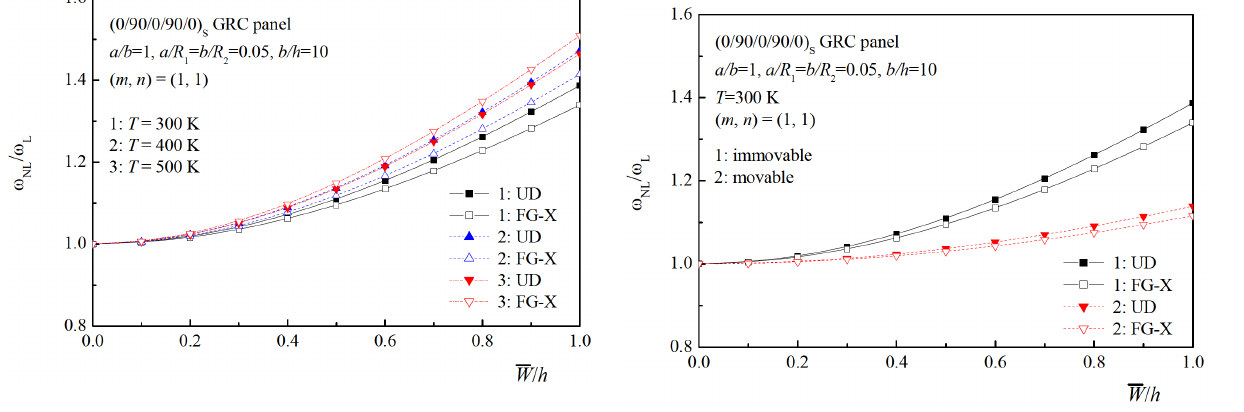
FG- Λ type with [(0.03) 2 /(0.05) 2 /(0.07) 2 /(0.09) 2 /(0.11) 2